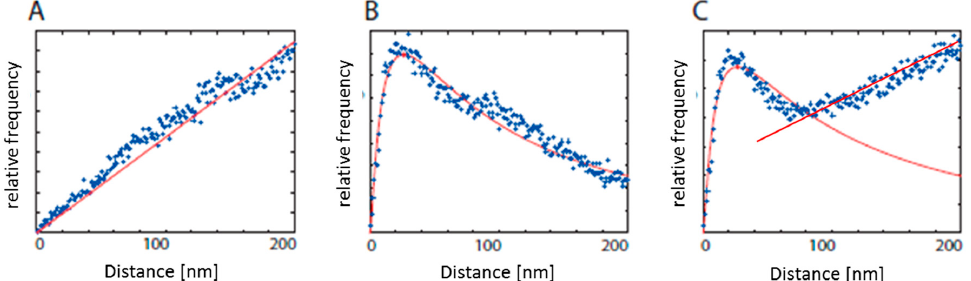
Figure 1. Schematic description of results obtained from localization microscopy. Blue points represent the measured frequencies of distances usually obtained from several cells of a specimen; the red curve represents the calculated envelope. The data points presented in this figure were taken from different specimens and different labels, showing the structural characteristics being described. ( A ) Distribution indicating a random arrangement of molecules; ( B ) structured organization with a characteristic dimension indicated by the maximum of the theoretical curve (red point); ( C ) organized structure implemented in randomly-distributed molecules.